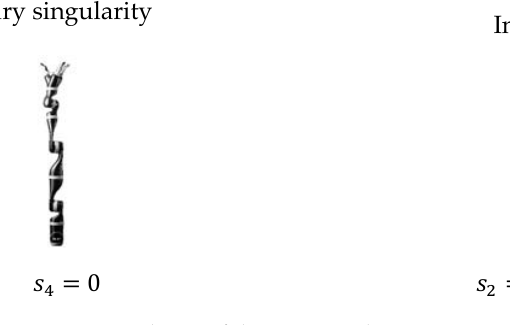
Figure 2. Position singularity of the JACO2 robot. Table 3. The position singularity condition.